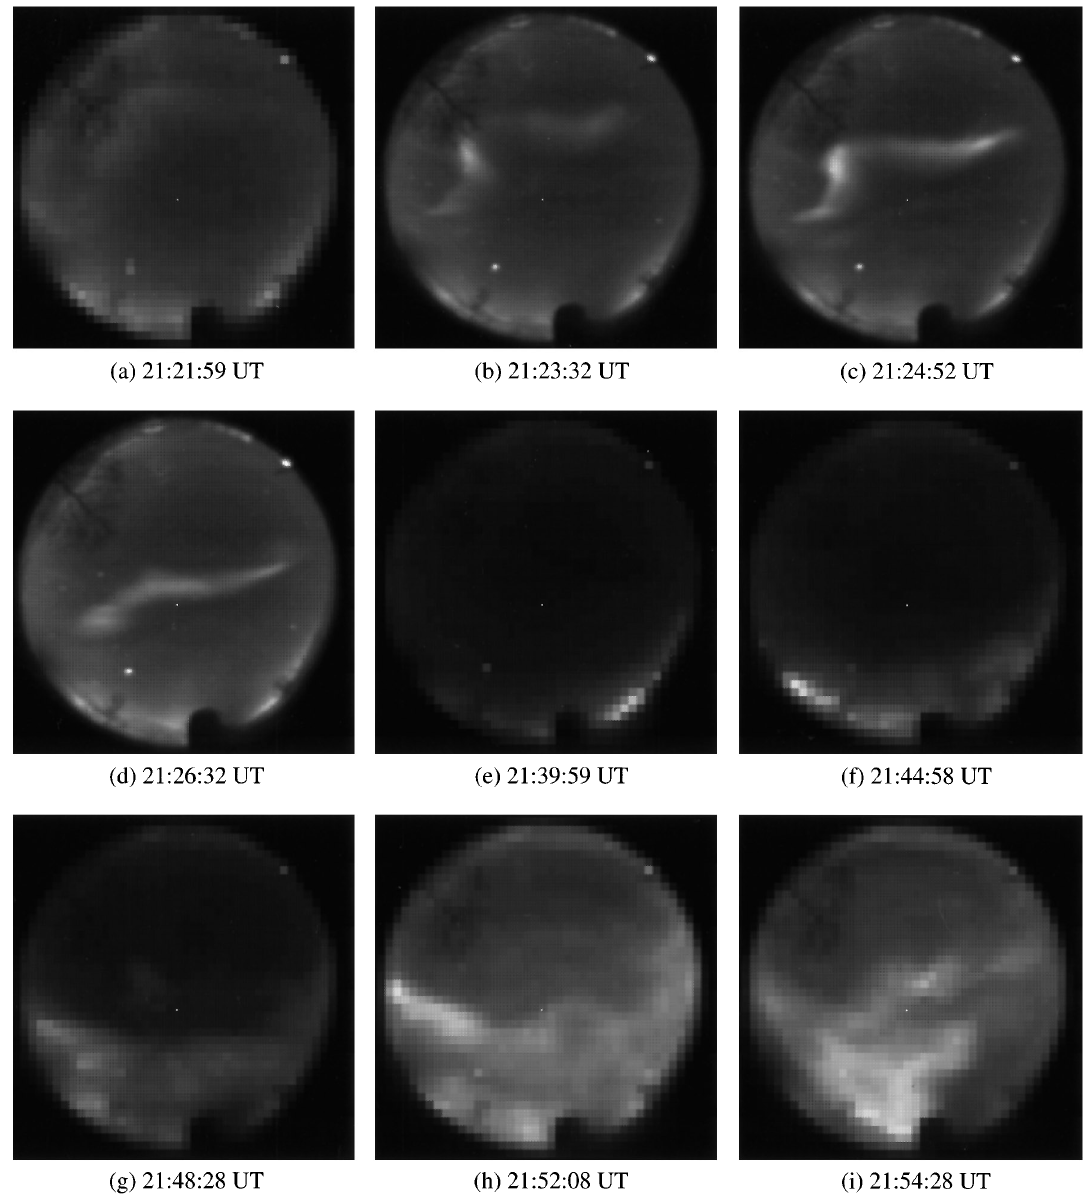
right. The mosaic effect on some of the pictures is due to the dynamic resolution adopted to solve data storage